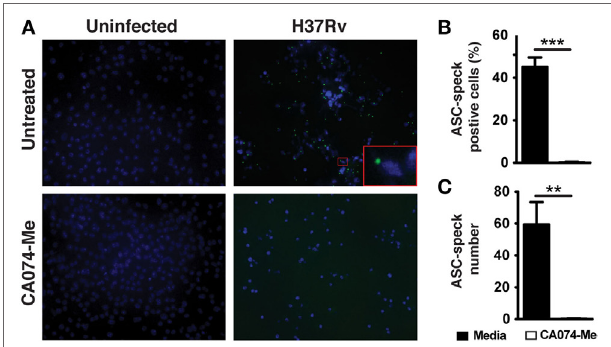
FigUre 4 | Cathepsin B (CTSB) activity mediates ASC speck formation. Macrophages were infected with Mycobacterium tuberculosis H37Rv MOI of 3 as described in Section “Materials and Methods” and cells were treated or not with the CTSB inhibitor CA074-Me as indicated. (a) ASC speck formation in infected macrophages treated or not with CA074-Me (25 µM) was analyzed by fluorescence microscopy. (B) The frequency of cells ASC speck positives (c) and number of ASC speck were quantified by using the Image J software. Differences were analyzed using the Mann–Whitney U test. Statistical differences observed are shown for each indicated groups (*** p < 0.001). Data represent mean ± SEM of samples ran in triplicate. Results are representative at least two independent